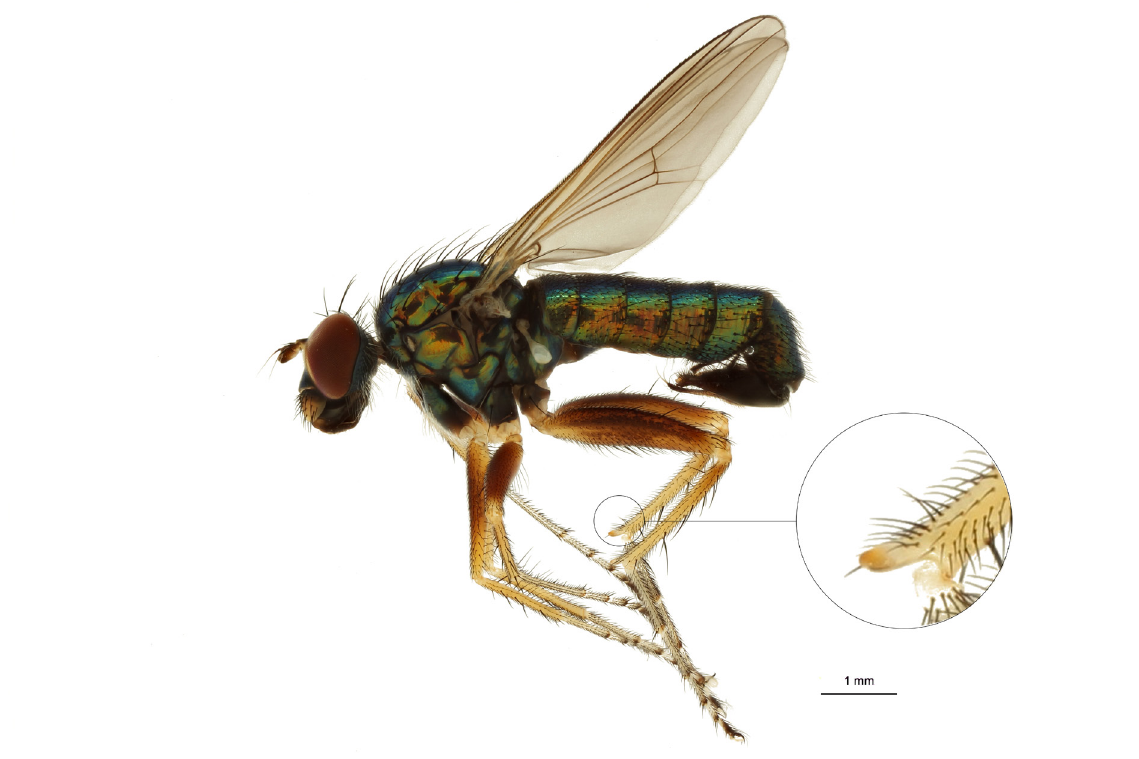
Fig. 5. Thinophilus plektron Samoh & Grootaert sp. nov. Male habitus (Abdulloh Samoh leg., PSUNHM